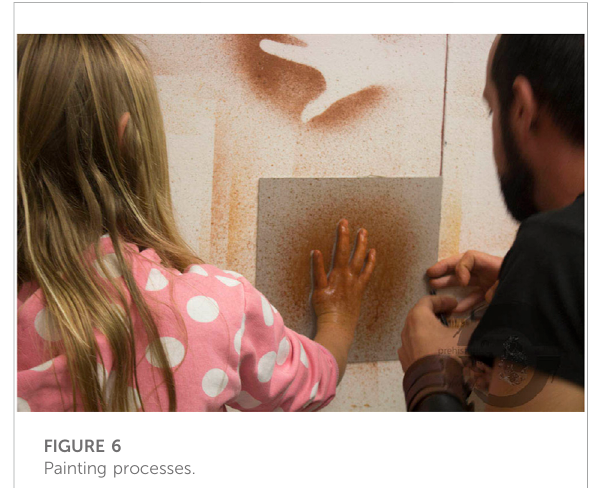
FIGURE 6 Painting processes.